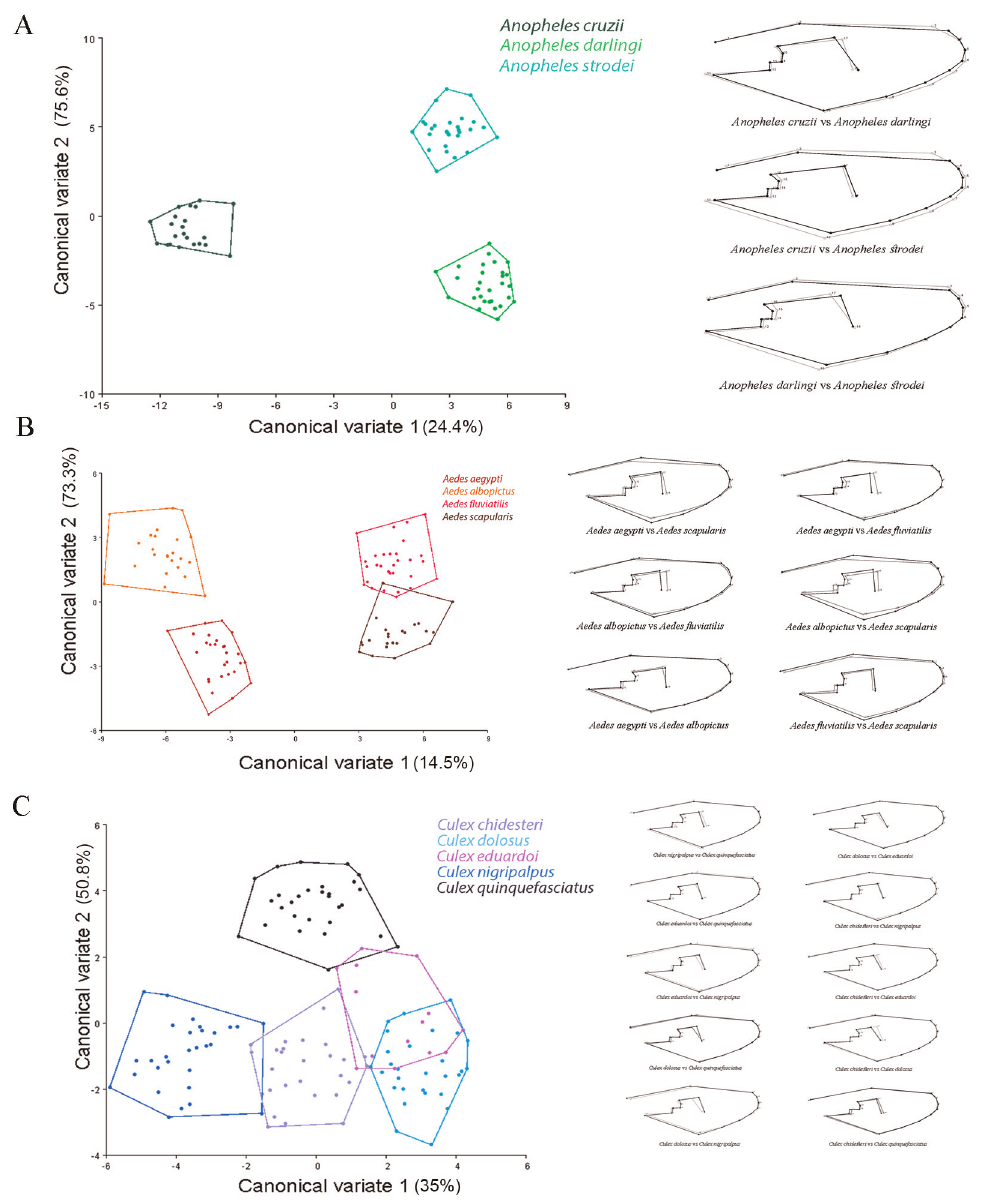
Fig 2. Morphological space produced by CVA of species and shape variations in a wireframe graph. A. Anopheles genus. B. Aedes genus. C. Culex genus. Shape variations in a wireframe graph are shown to the right of each morphological